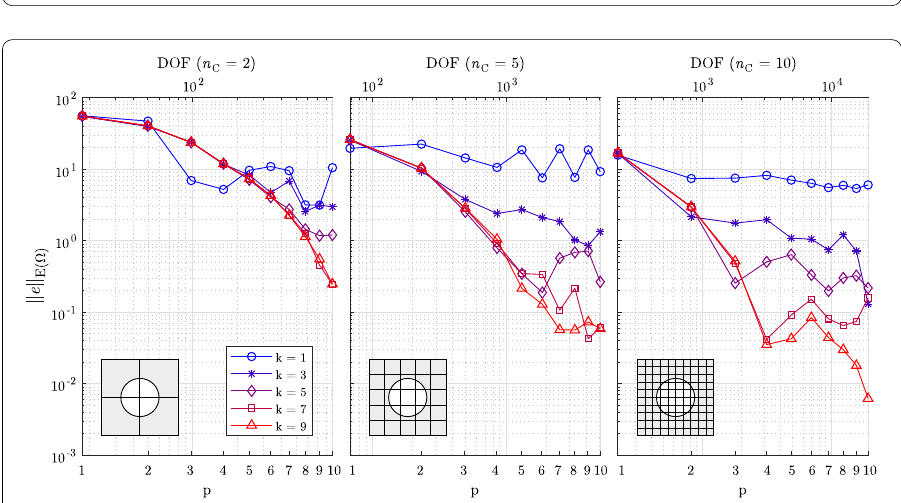
Fig. 21 Setup of the perforated plate under investigation. The given dimensions are understood in (mm)